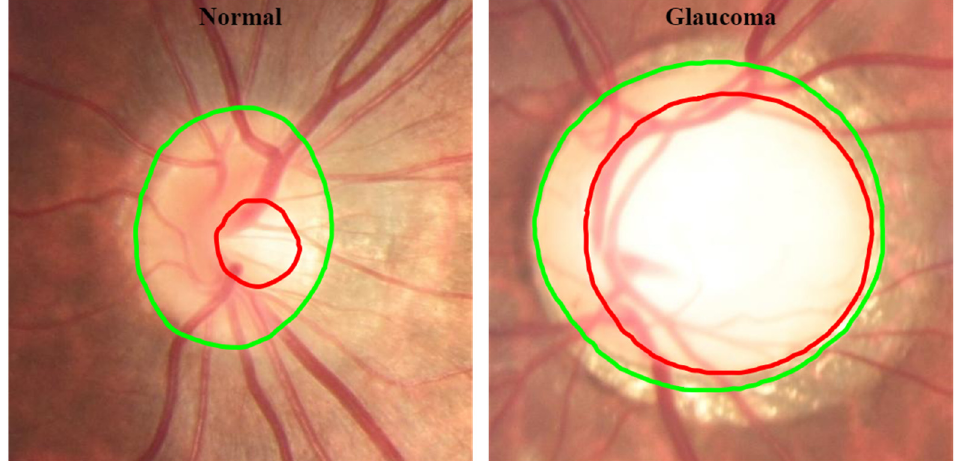
Figure 2. Retinal image from the normal and glaucomatous eye. Green line: OD boundary; red line: cup boundary.